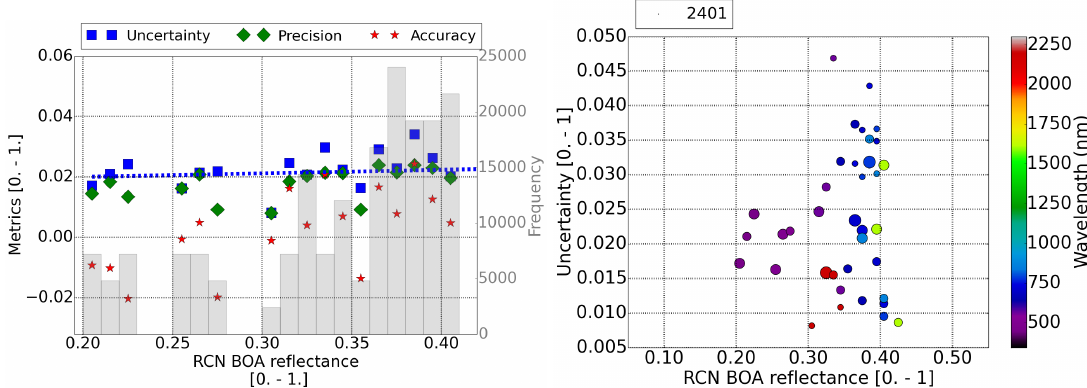
Figure 7. ( Left ) Distribution of the accuracy, precision, and uncertainty of Sentinel-2 surface reflectance as a function of the reference surface reflectance for the Railroad Valley Playa RadCalNet site. The number of pixels included in each bin are shown in the shadow histogram and on the right axis. Uncertainty fit is displayed as the dotted blue line. ( Right ) Uncertainty of the surface reflectance versus the reference value and the band central wavelength. The size of the points scales with the amount of pixels analyzed in each point. The amount of pixels considered for the smaller point is displayed in the legend. In both plots, the swir band (2250 nm), cirrus band (1380 nm), and water absorption bands at 940 nm have been discarded.